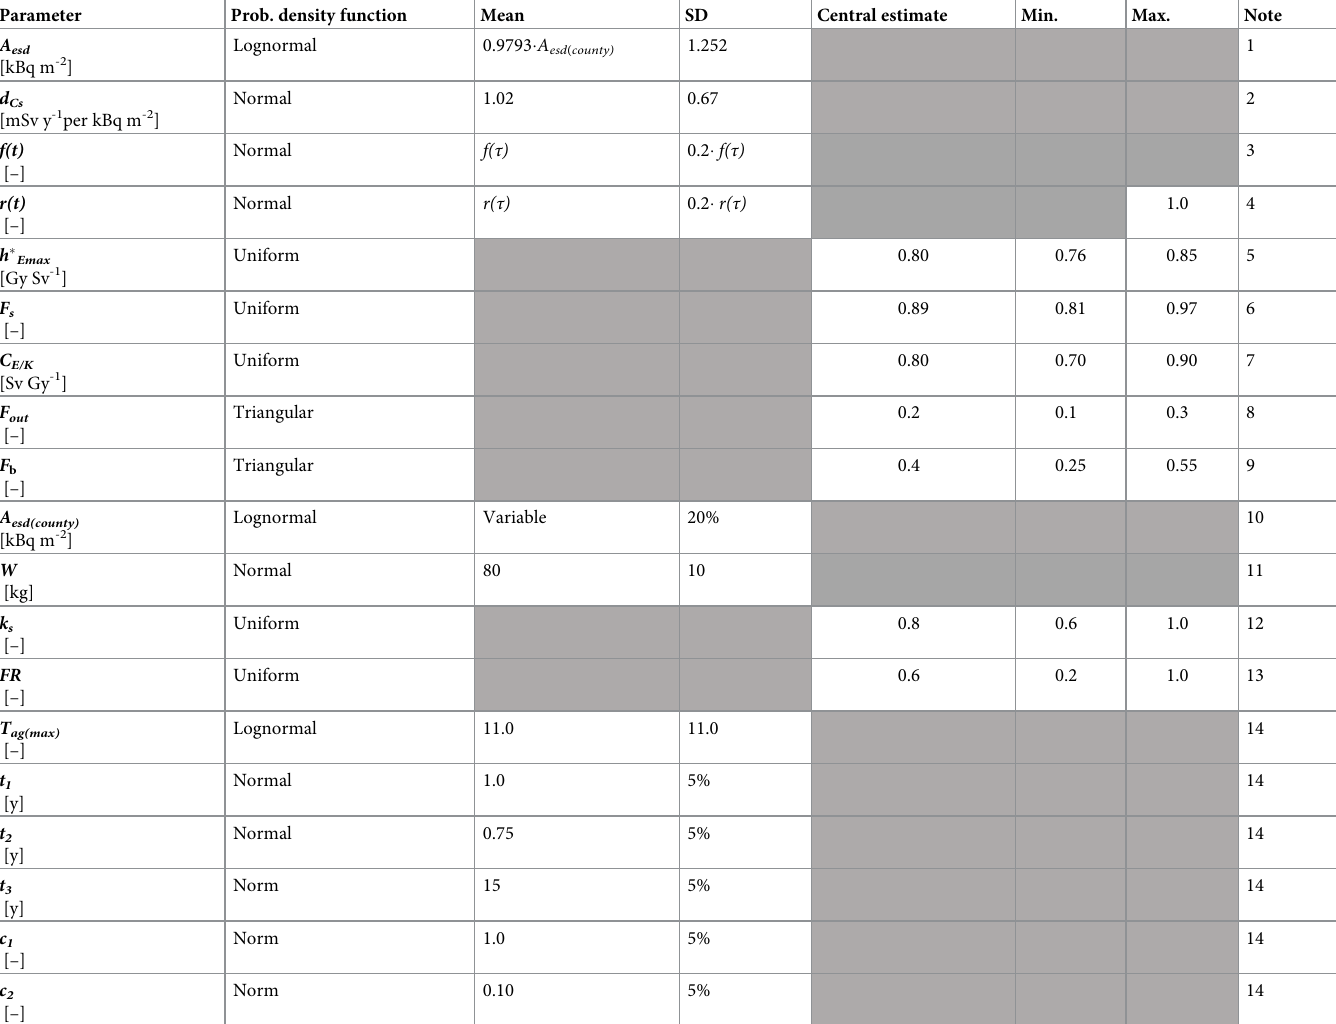
Table 4. Parameter values and probability distributions used in the sensitivity analysis. Central estimates of parameters were those used in the standard scenario (S). The references for the choice of the minimum and maximum parameter values are given in the footnotes. Gray shading indicates parameters that are not applicable for the respective type of